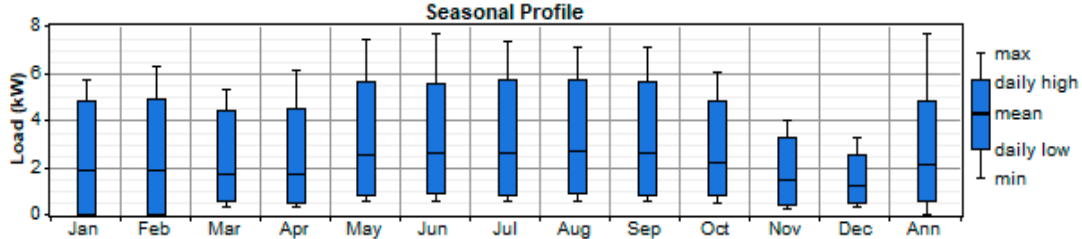
Figure 4. Seasonal load profile.